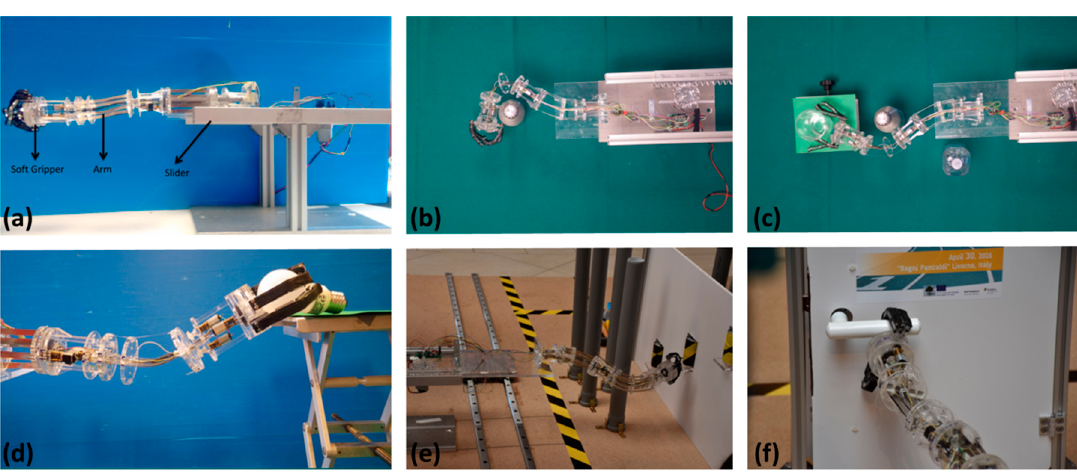
Figure 13. First prototype of SIMBA and its capabilities at different tasks. ( a ) Full assembled design of the manipulator [16]; ( b ) bending capability; ( c ) dexterity; ( d ) capacity to bend and rotate for manipulation task; ( e ) arm positioning; ( f ) door opening.